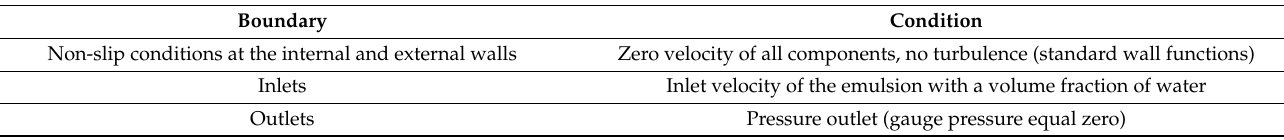
Table 4. Boundary